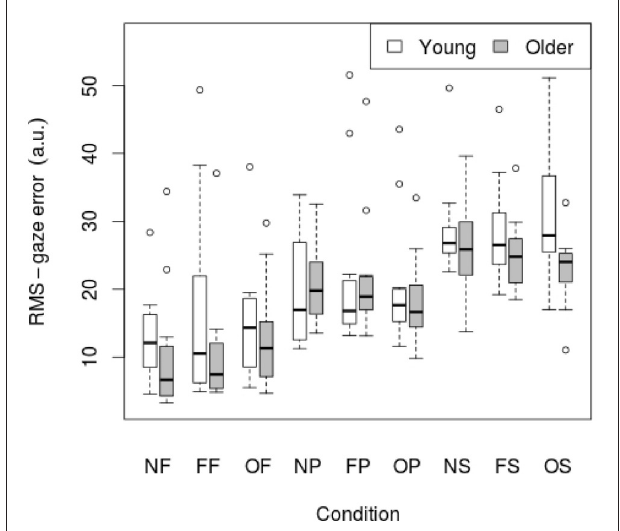
FIGURE 3 | RMS of gaze subtracted from target position for young ( n = 12) and older ( n = 12) participants during different visual scene conditions. D, dark; N, none; F, fixed; O, oscillating; P, pursuit; S, saccadic. Data are displayed as medians and lower and upper quartiles with Tukey style whiskers (outliers plotted